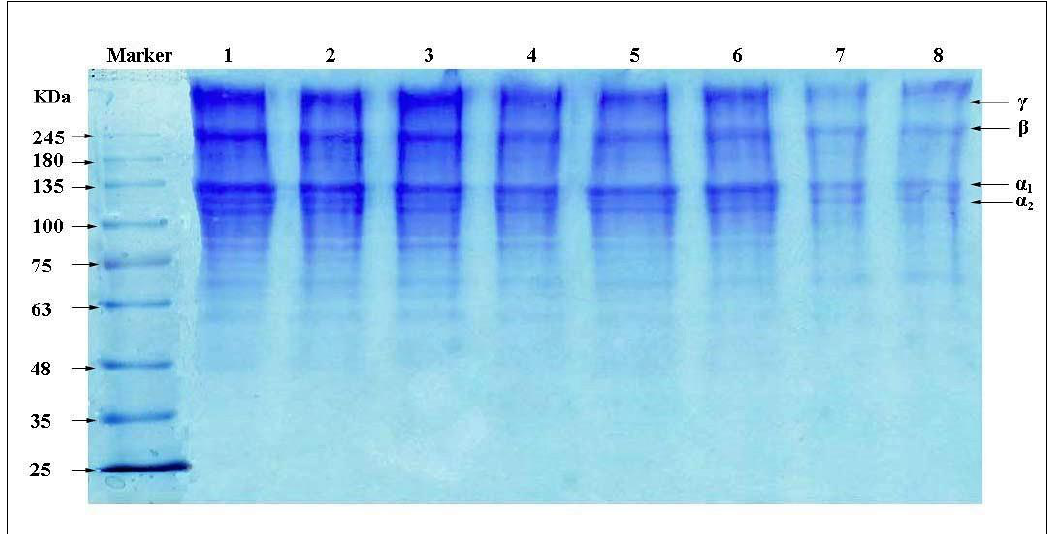
Figure 1. SDS-PAGE patterns of A-CF (column 1, 2, 3), P-CF (column 4, 5, 6) and COL (column 7, 8).